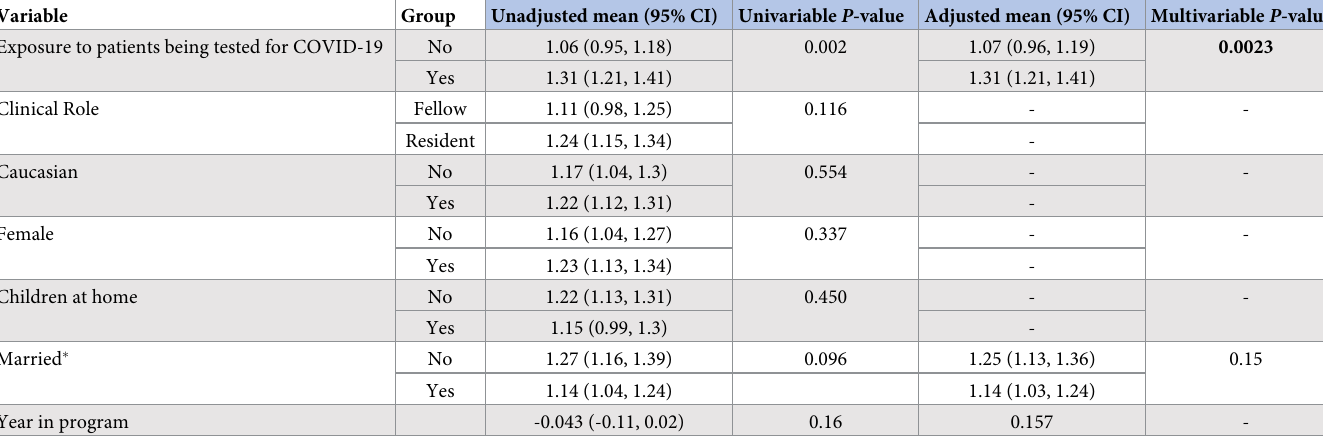
Unadjusted means correspond to means and slope (year in program) unadjusted for covariates. Adjusted means correspond to means from multivariable models adjusted for those covariates that had P < 0.10 in univariable